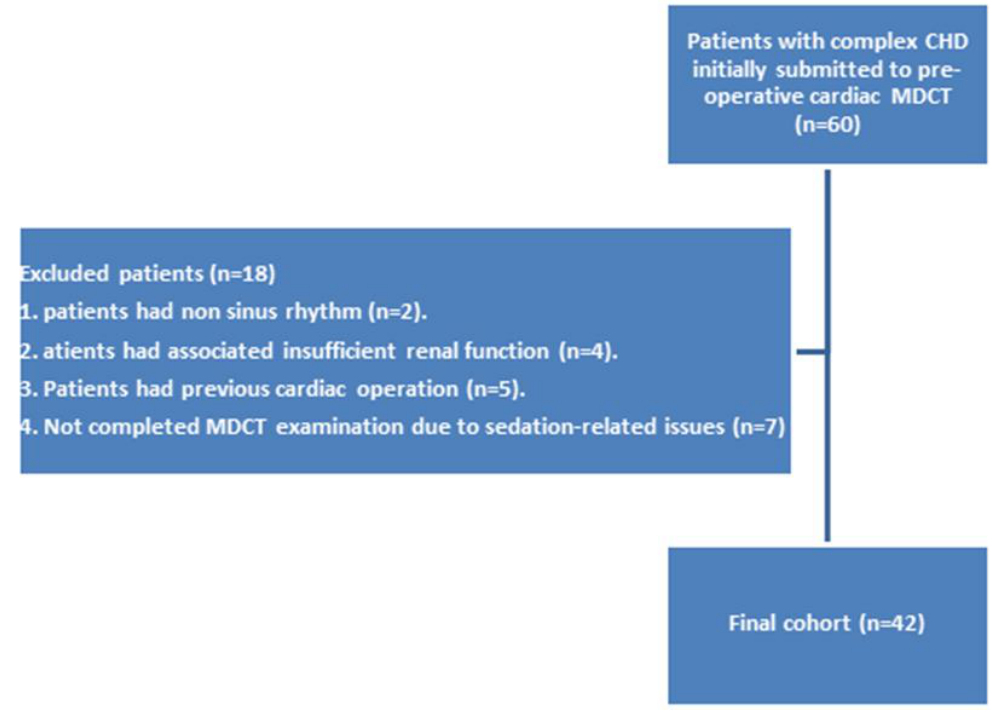
Figure 1. Flow chart of the study. Table 2. Demographic data of the patients. Table 3. Clinical and laboratory findings and associated comorbidities and